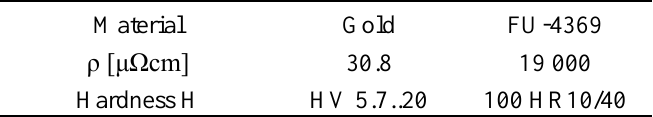
Table 1. Material constants of the contact partners